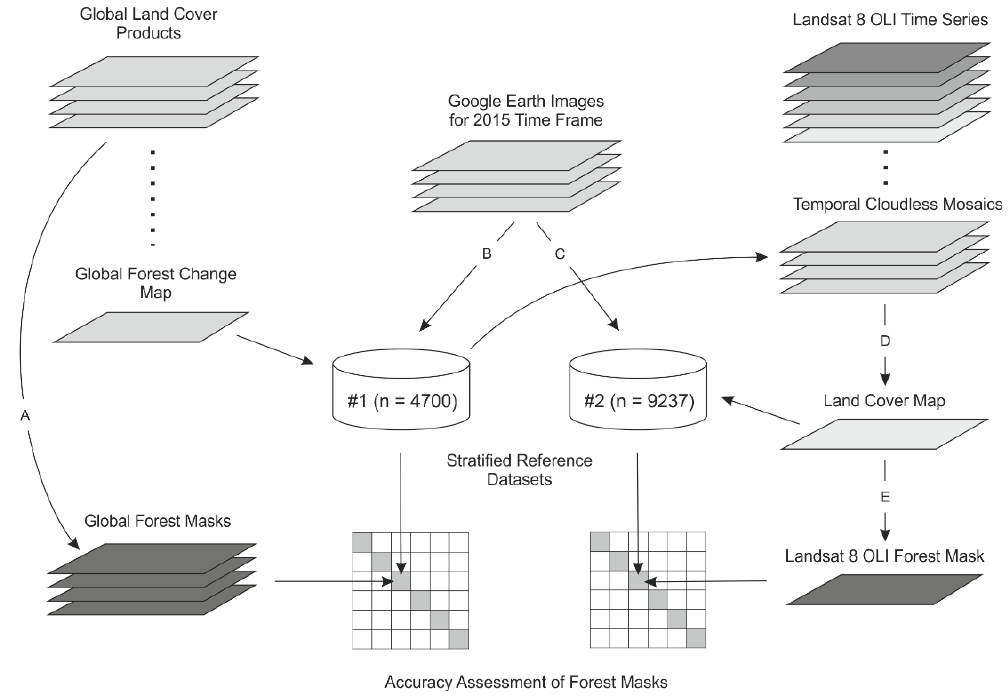
Figure 3. Flow-chart illustrating the use of global forest products and Landsat 8 OLI satellite imagery in the current study: A–threshold (GFC and LTCCF) or binary (JAXA-FNF and GlobeLand30) classifications; B,C–visual interpretation of historical Google Earth images for training and validation; D–random forest classification; E–binary classification.